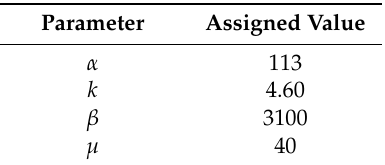
Table 1. Scaling